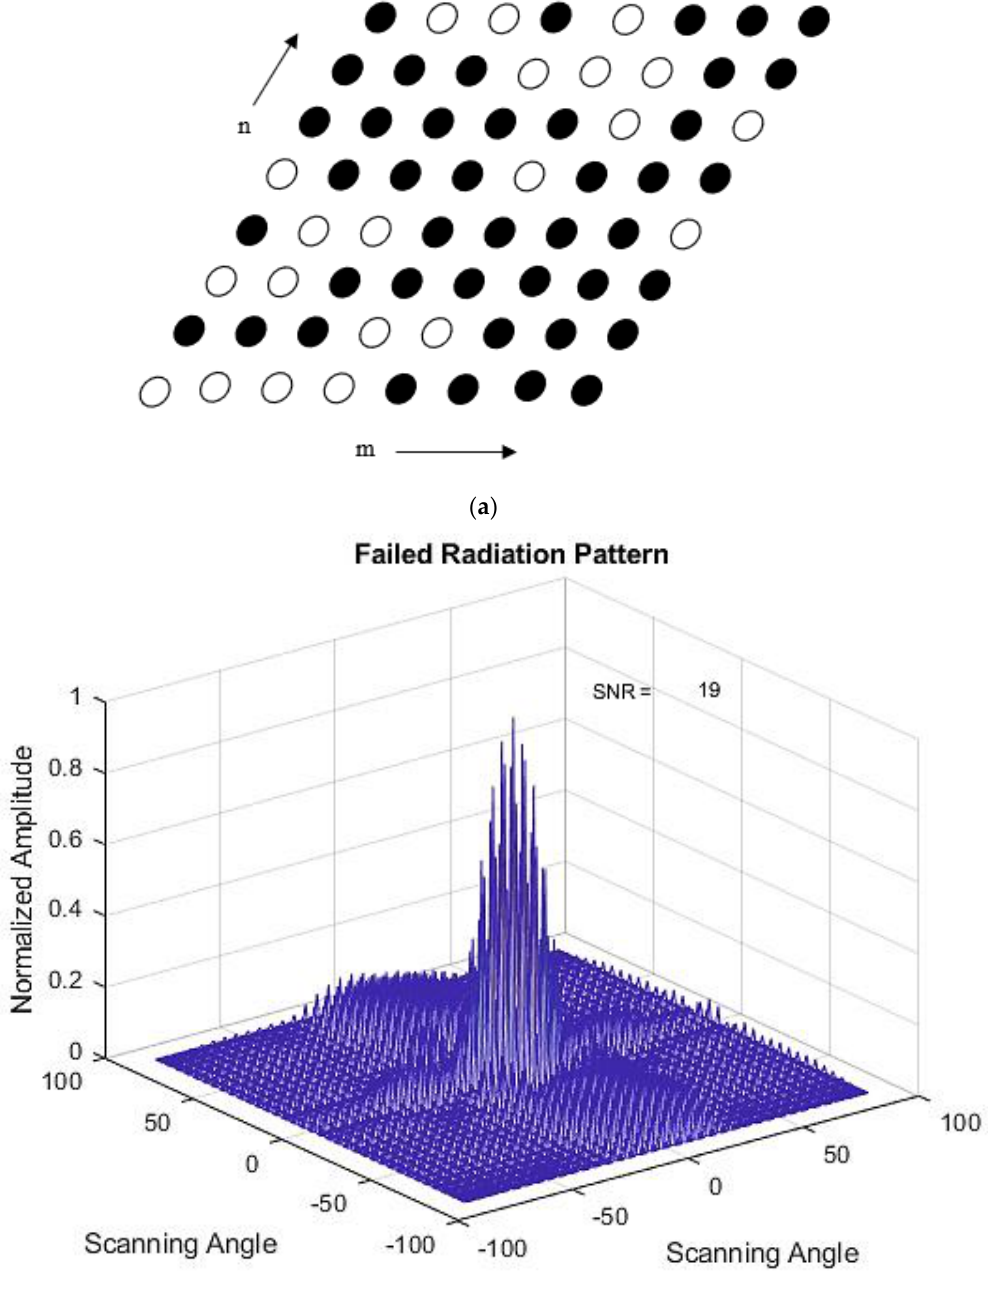
Figure 5. ( a ) 25 Failed Elements at 8 × 8 planar array. ( b ) Failed Radiation Pattern of an 8 × 8 planar array with 25 failed elements in the array.